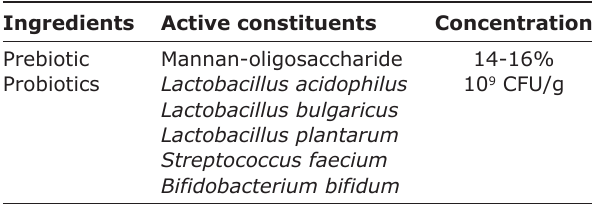
Table-2: Active principles present in synbiotic used in the experimental trial. Ingredients